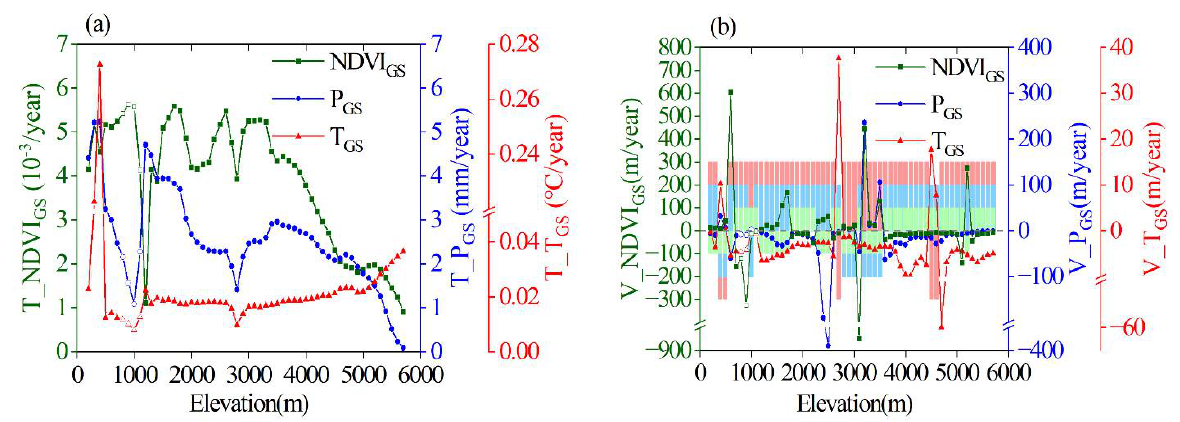
Figure 4. ( a ) Temporal trends in the growing season NDVI (NDVI GS ) (T_NDVI GS ; green line; values on left-hand y -axis (×10 −3 /year)), growing season precipitation (P GS ) (T_P GS ; blue line; values on right-hand y -axis (mm/year)), and growing season temperature (T GS ) (T_T GS ; red line; values on right-hand y -axis (°C/year) plotted against the elevation. The unfilled symbols indicate where the number of valid pixels in the interval was less than 1000. ( b ) The vertical velocity of the growing season NDVI (V_NDVI GS ; green line; values on left-hand y -axis), growing season precipitation (V_P GS ; blue line; values on right-hand y -axis), and growing season temperature (V_T GS ; red line; values on right-hand y -axis) plotted against the elevation. The unfilled points indicate where the number of effective pixels in the interval was less than 1000. A positive velocity of the vertical movement of the NDVI GS , P GS , and T GS isolines (V_NDVI GS , V_P GS and V_T GS , units: m/year) indicated upward movement of the isolines. The direction of the vertical movement of the NDVI GS , P GS , and T GS isolines is indicated by the short green, medium blue, and long red bars, respectively: above zero indicates upward and below zero indicates downward.